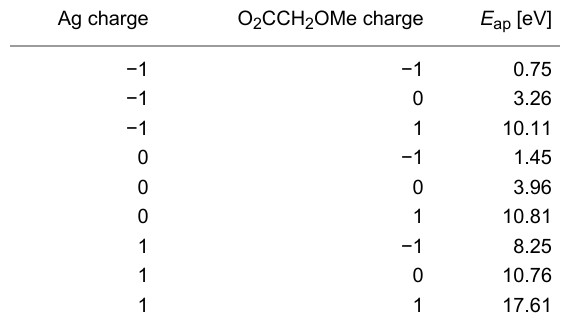
Table 4: Appearance energy (Equation 2) of differently charged Ag and O 2 CCH 2 OMe fragments from dissociation of [AgO 2 CCH 2 OMe] − . Ag charge